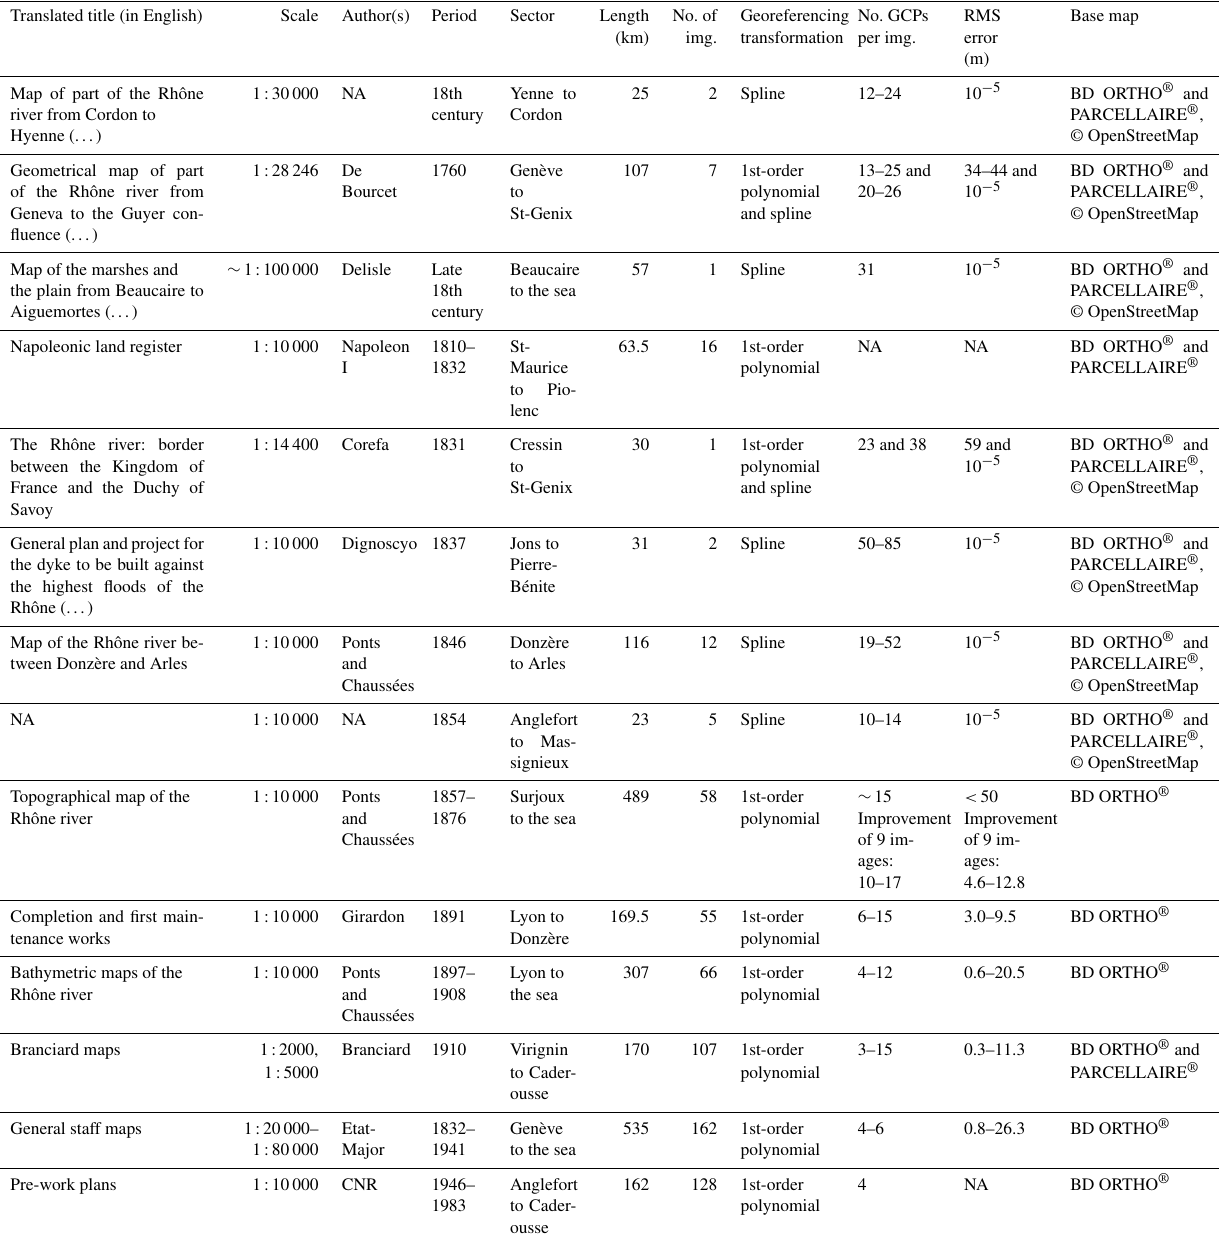
Table 2. Georeferencing information on 14 map series of the database. The BD ORTHO ® and PARCELLAIRE ® base maps are provided by the